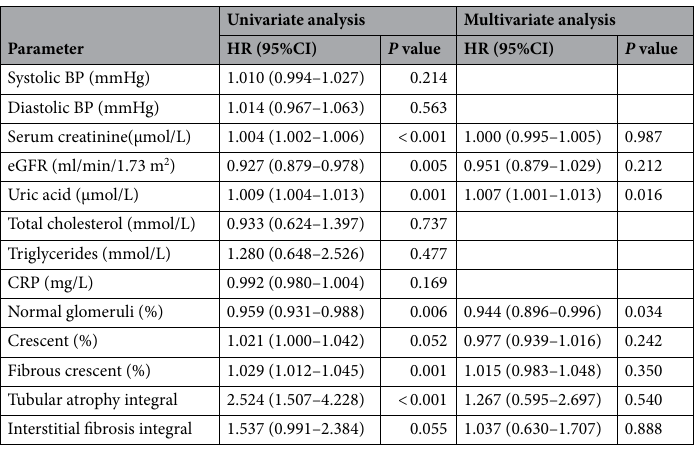
Table 5. Cox proportional hazard regression model describing long-term risk of ESRD of ANCA-related renal vasculitis patients.